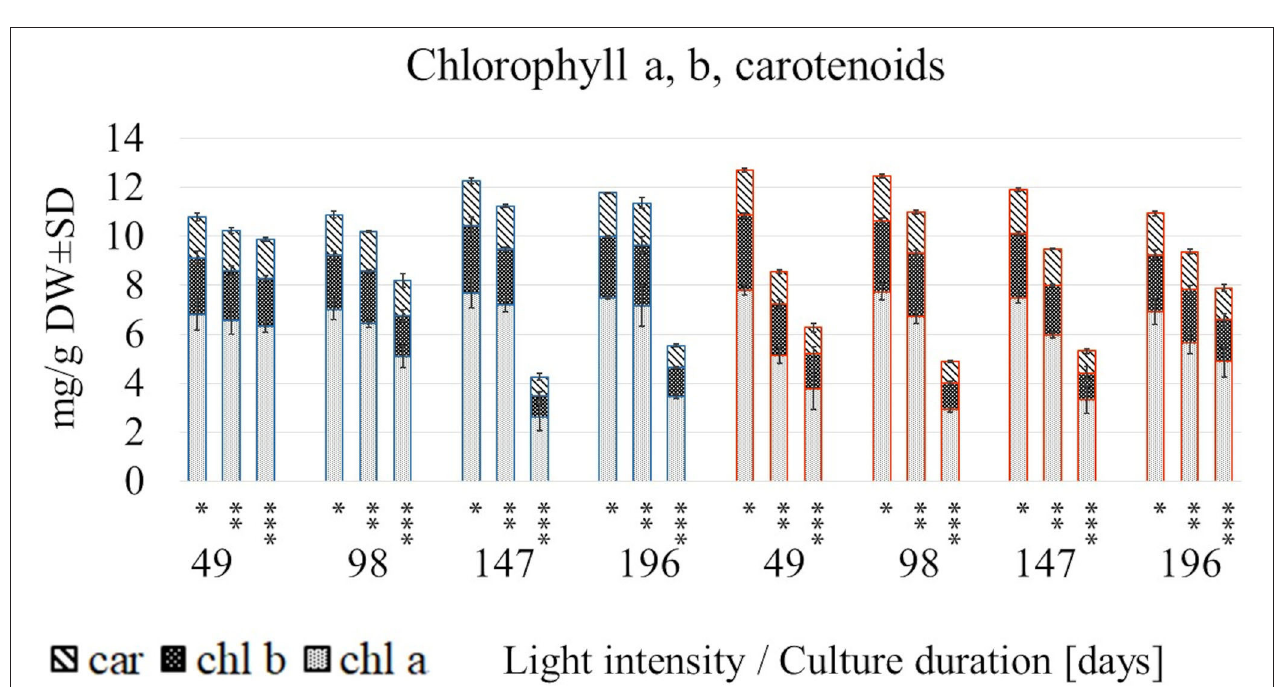
FIGURE 2 | The content of chlorophyll a, b and carotenoids in S. yangii shoots cultured in different LI and temperature regimes; *70 µ mol m − 2 s − 1 ; **130 µ mol m − 2 s − 1 ; ***220 µ mol m − 2 s − 1 ; blue: 25 ◦ C, red: 30 ◦ C.